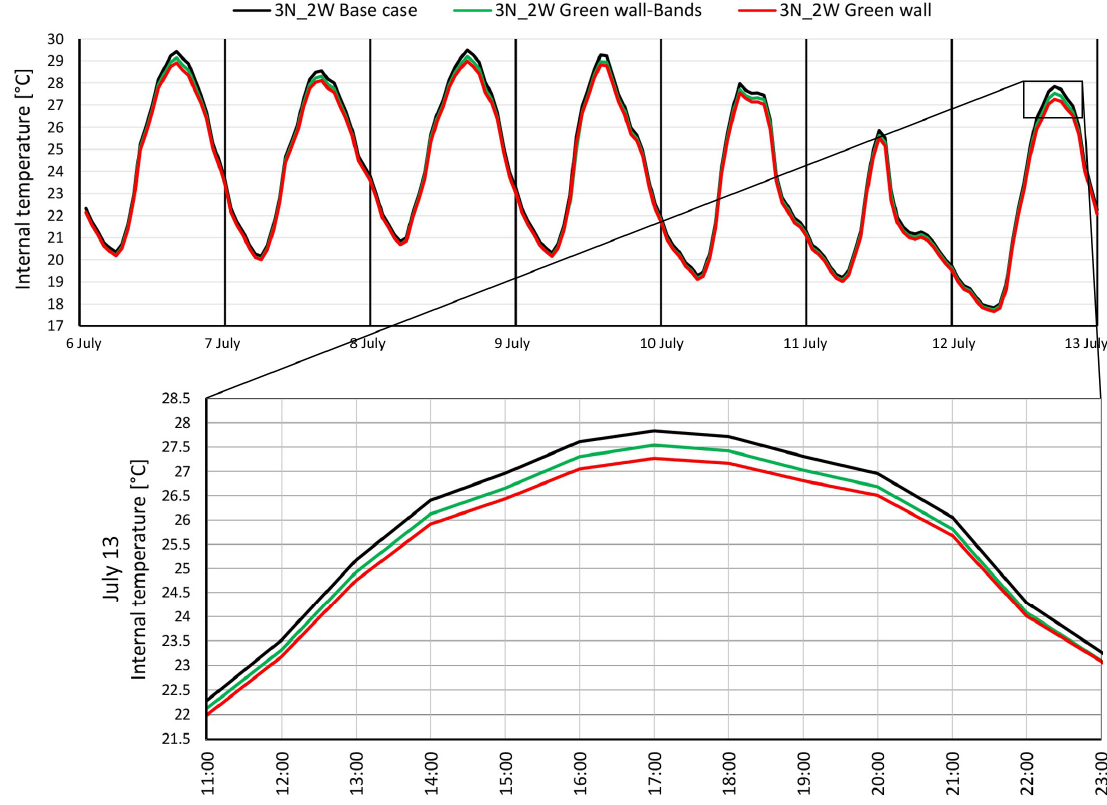
Figure 4. Variation of the value of internal air temperature for the three different configurations considered. The green whole and the green wall-bands were installed for each orientation. In the figure, data from the reference 13th of July is reported.